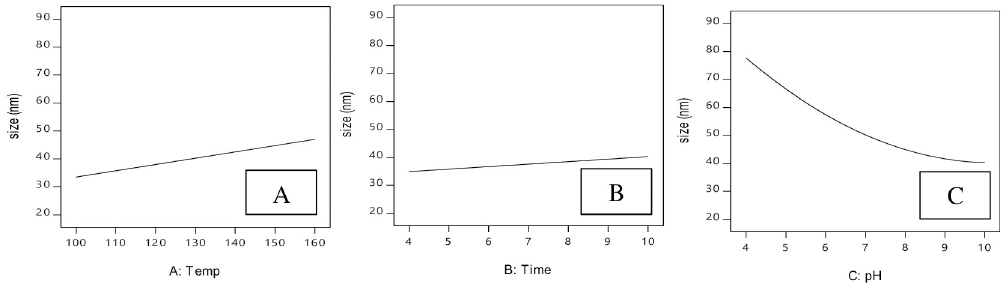
Fig 12. Effect of process parameter on crystal size. A: Hydrothermal temperature, B: hydrothermal reaction time, C: pH.